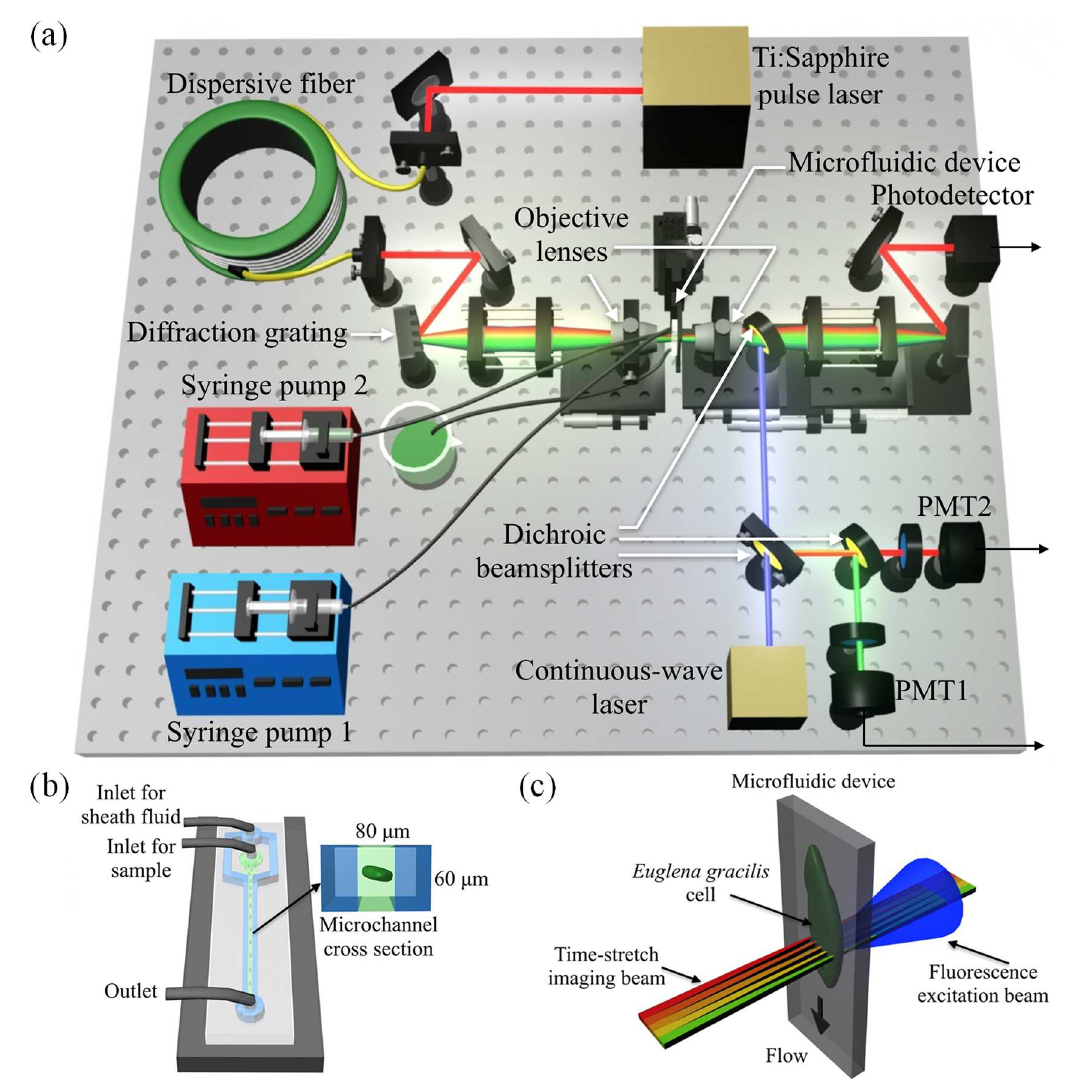
Fig 1. Optofluidic time-stretchmicroscope. (a) Schematic of the microscope. It consists of an optical time-stretch microscope, a two-channel fluorescenceanalyzer, a hydrodynamically focusing microfluidic device. The optical time- stretch microscope can image every single cell at a high throughput of 10,000 cells/s while the fluorescence analyzer can simultaneously detect fluorescencefrom each cell. (b) Schematic of the microfluidic device. (c) Enlargedview of the optical